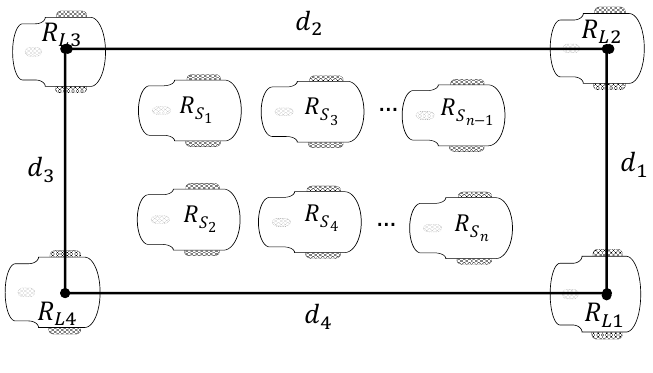
Figure 7. Position of the leaders and follower